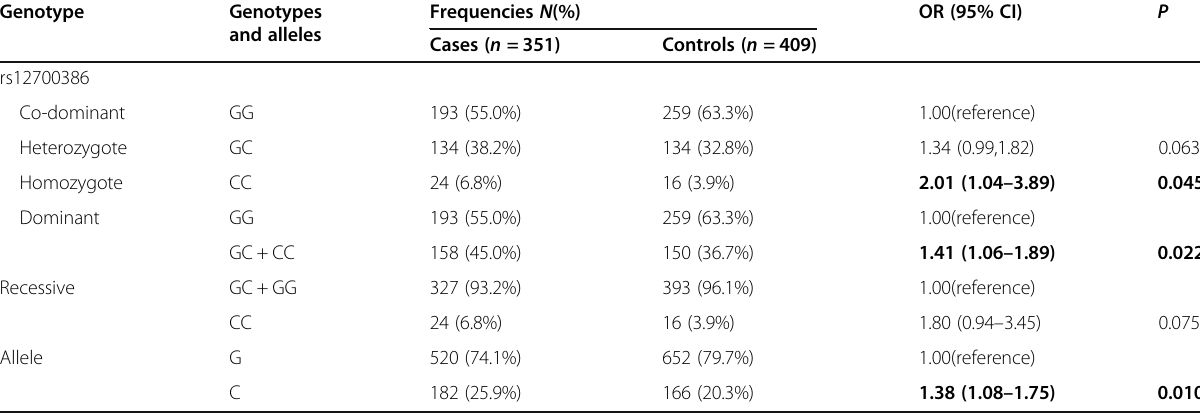
Table 2 The association of genotype and allele of IL-6 rs12700386 polymorphism with osteoarthritis risk